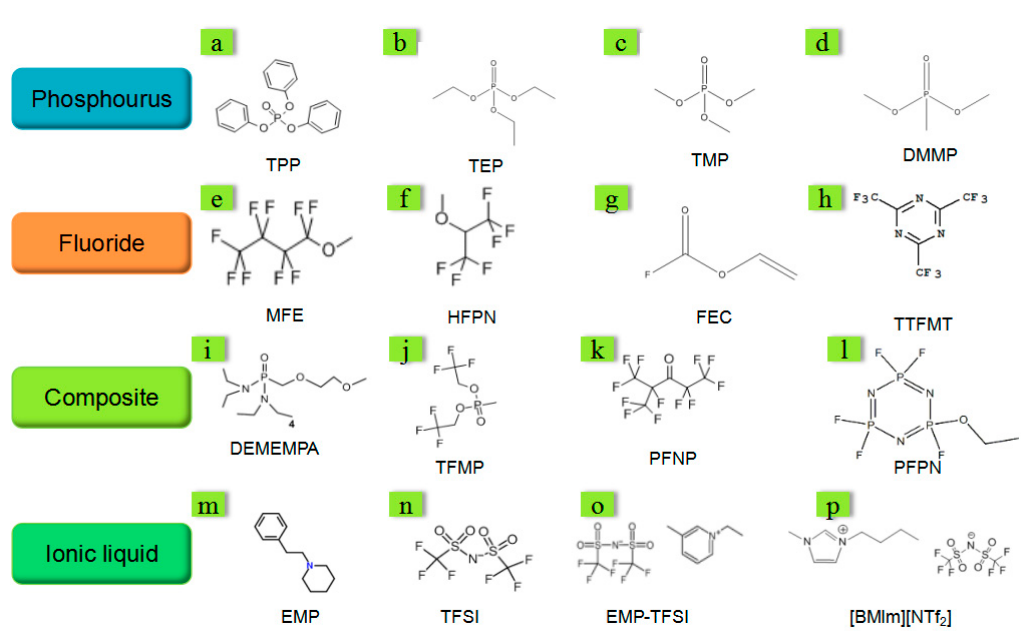
Figure 15. The chemical structures of several typical retardant electrolyte additives.